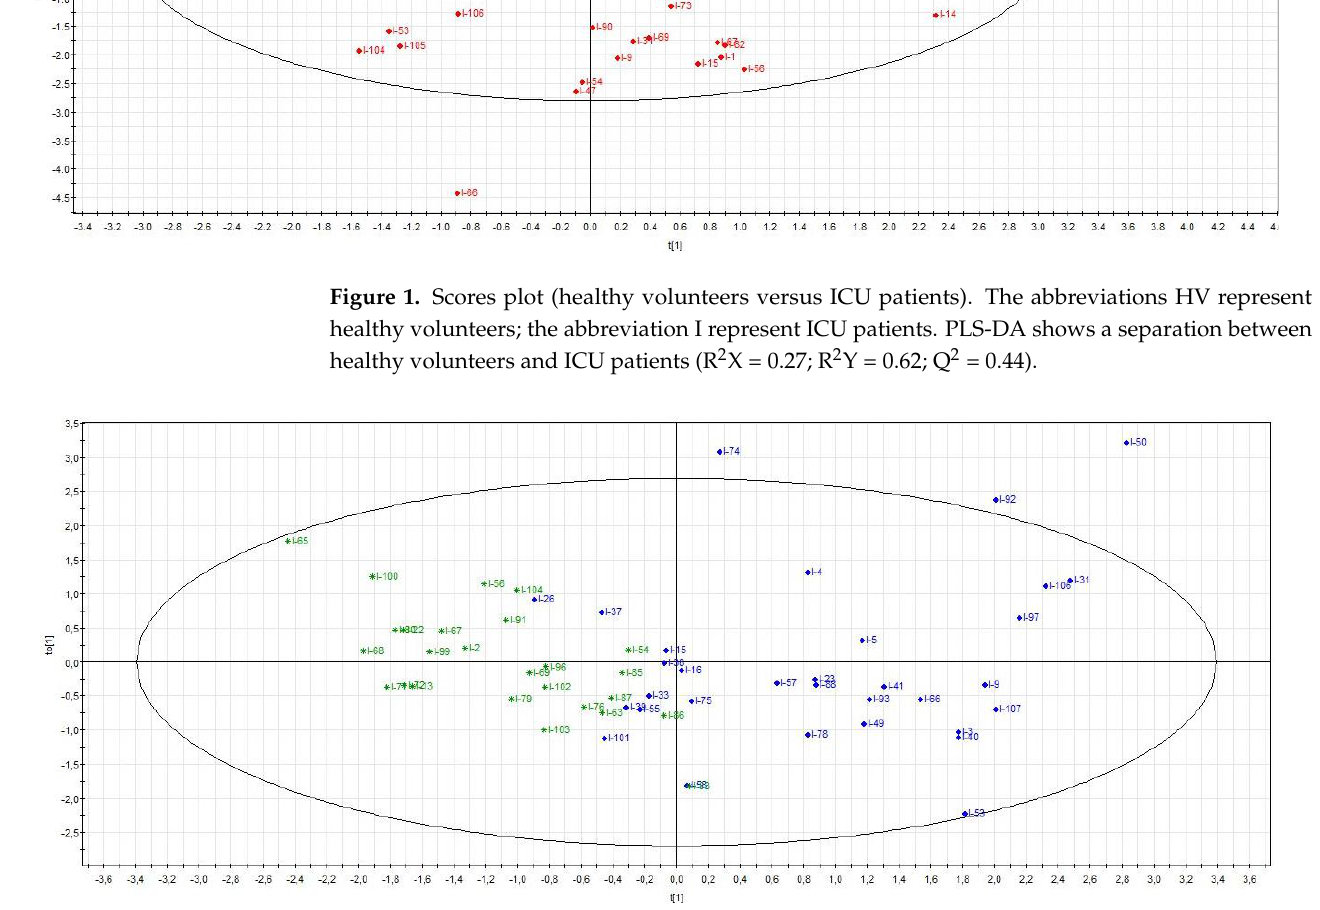
Figure 3. Loadings plot (septic shock versus ICU control group). Different expressions of metabo- lites between septic shock and ICU control group (R 2 X = 0.53; R 2 Y = 0.58; Q 2 = 0.29).